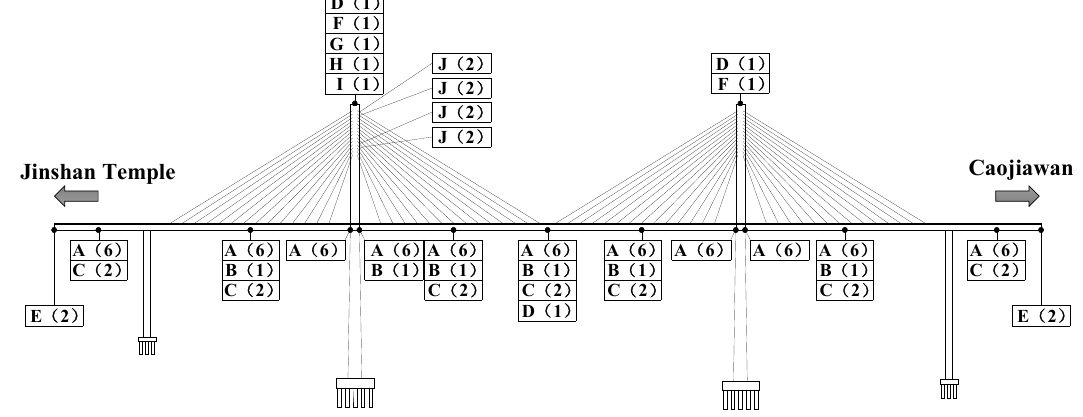
Figure 2. The overall layout of the sensor measuring point: A , the stress sensor (including temperature measurement as well); B , the acceleration sensor; C , the static level gauge; D , Global Navigation Satellite System (GNSS); E , Linear Variable Displacement Transducer; F , the tiltmeter; G , the temperature and humidity sensor; H , the pluviometer; I , the dogvane and anemoscope and J , the anchor cable meter through the cable. Also, the numbers in parentheses indicate the amount of each sensor.